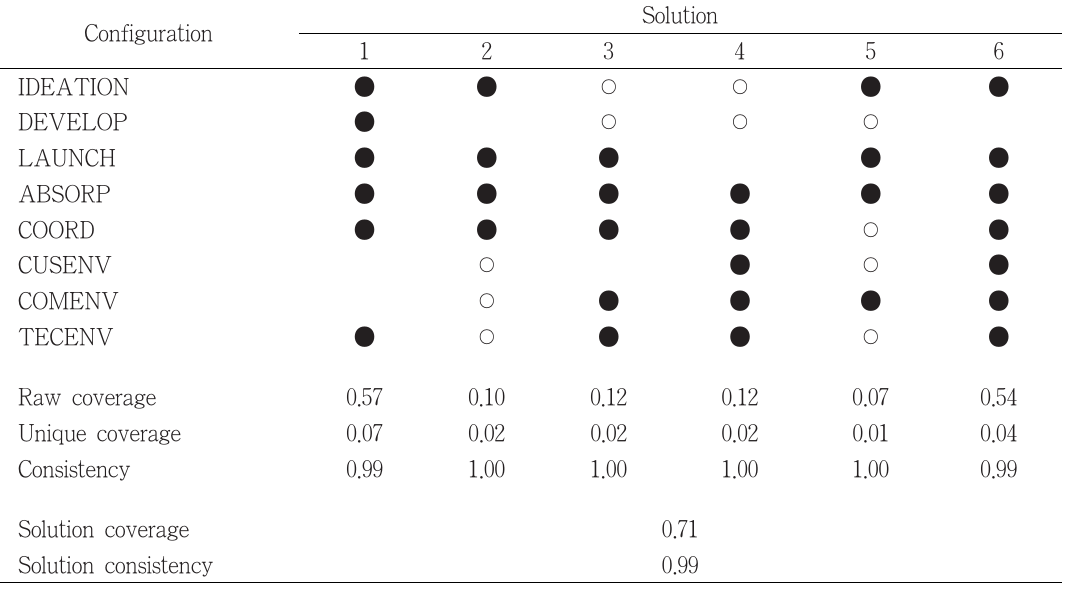
<Table 3> Solutions for Building Knowledge Benefit through Customer